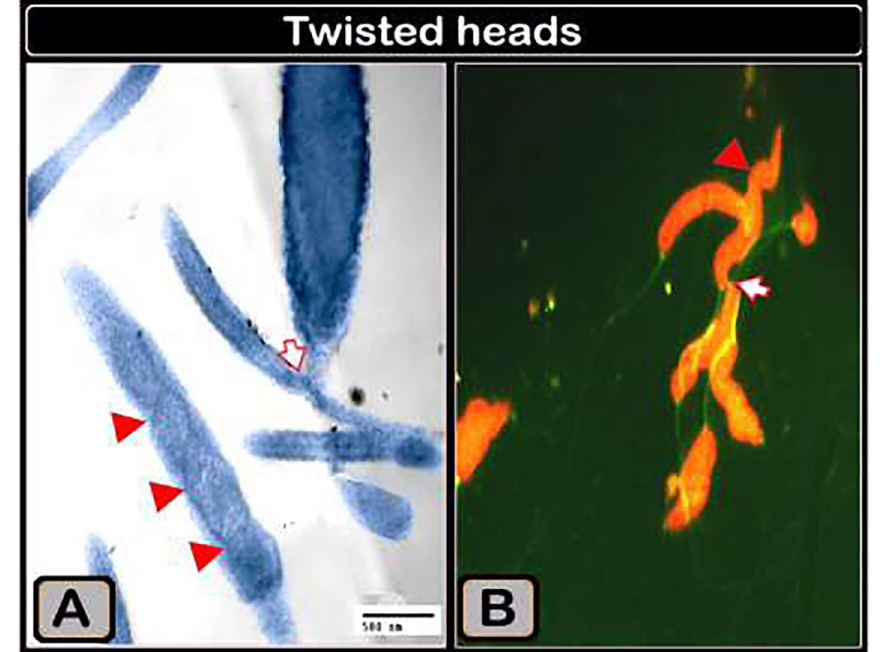
Figure 7. ( A ) Digital colored transmission electron micrograph and ( B ) acridine orange-stained semen smear showing twisted heads and attachment of sperm heads and tails (arrow). Magnification of ( B )